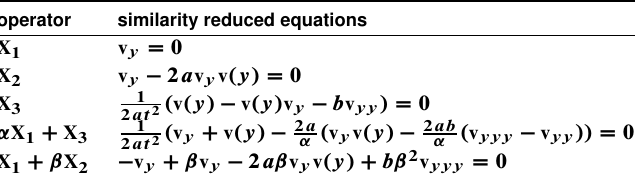
Table 6. Reduced equations (BBM equation)